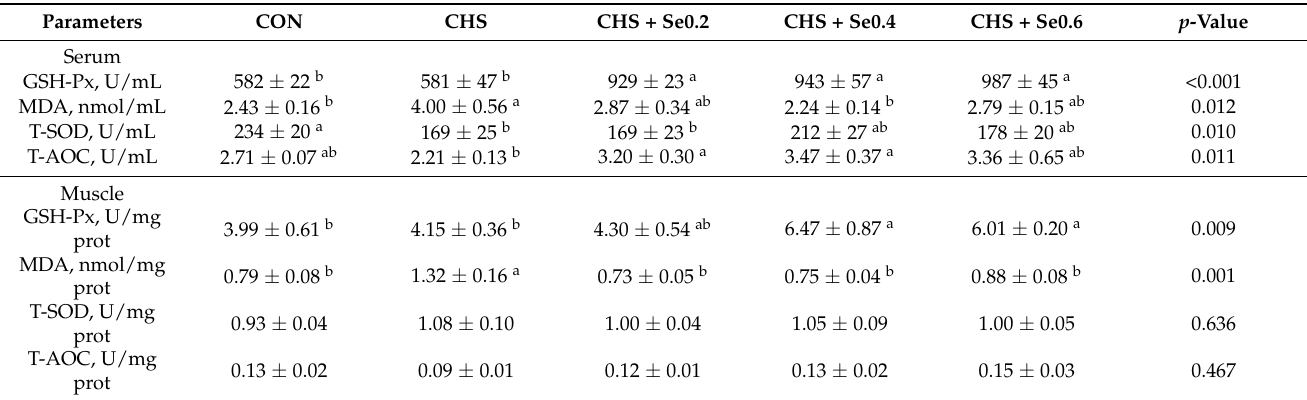
Table 5. Effects of CHS and OH-SeMet supplementation on serum and muscle antioxidant enzyme and malondialdehyde content of pigs.